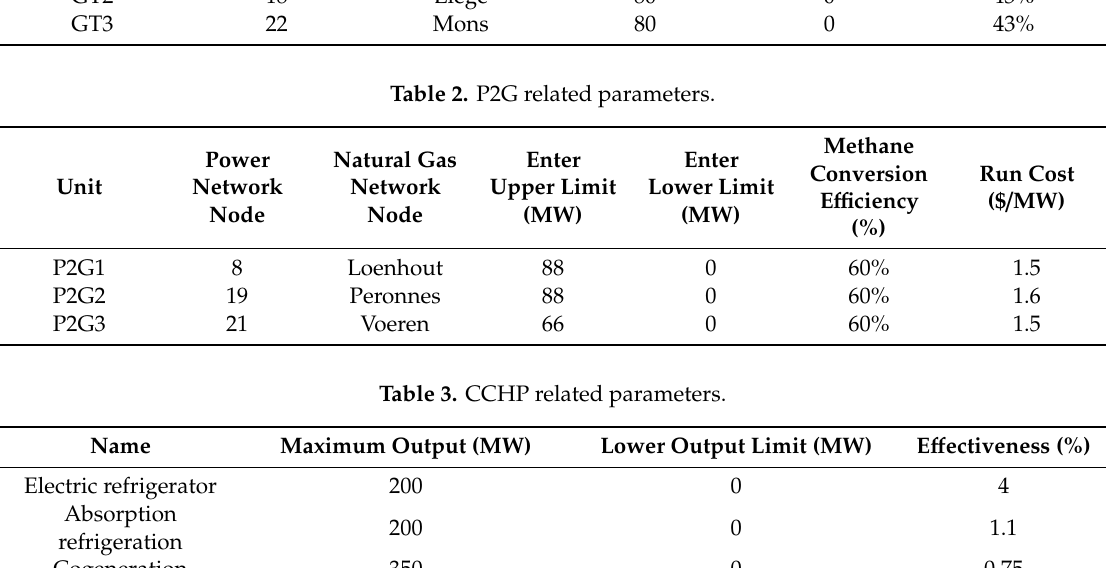
Table 3. CCHP related parameters.